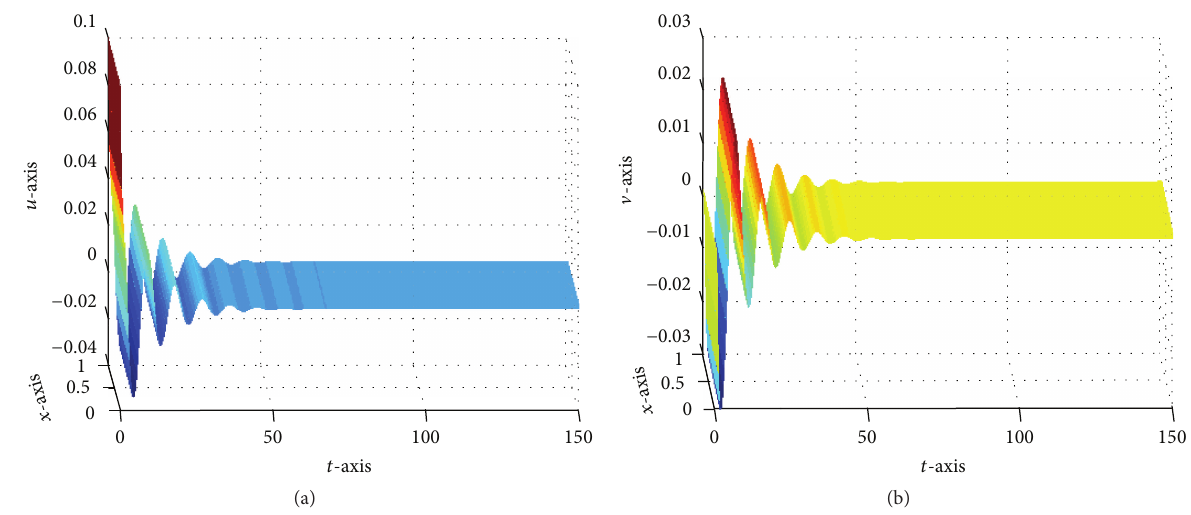
Figure 1: The temporal solution found by numerical integration of systems (64) and (66) with 𝜏 = 1.85 : (a) 𝑢(𝑡,𝑥) and (b) V (𝑡, 𝑥) .